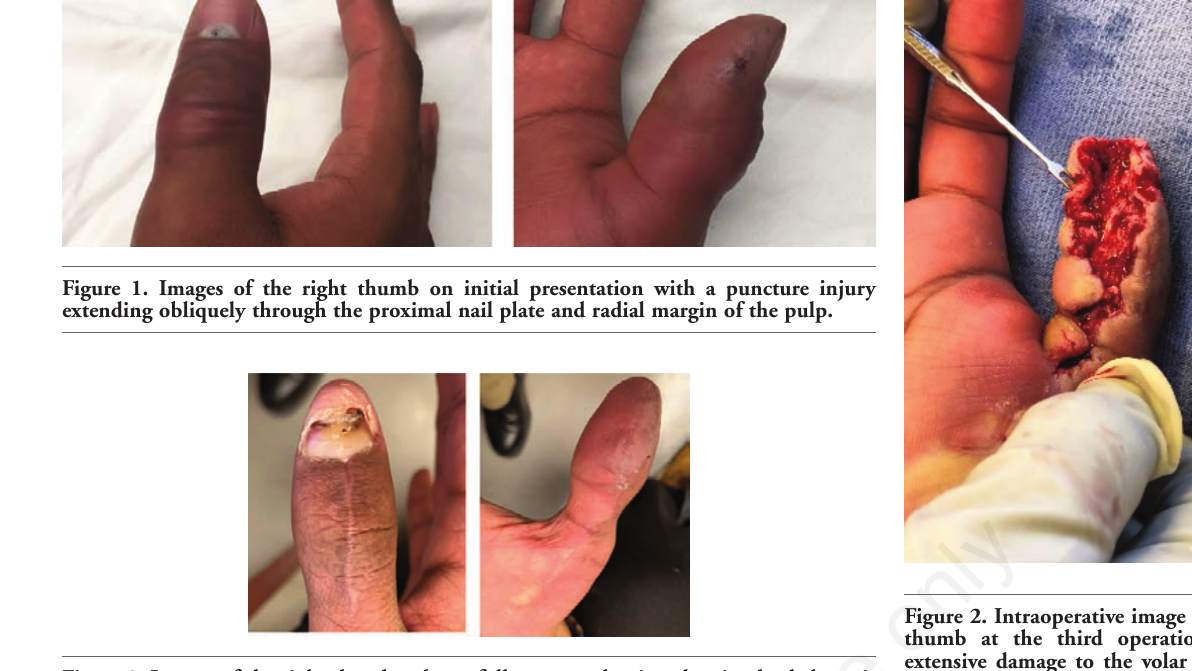
Figure 3. Images of the right thumb at latest follow-up evaluation showing healed surgi- cal incisions, scarring of the nail bed, and narrowing of the thumb tip.